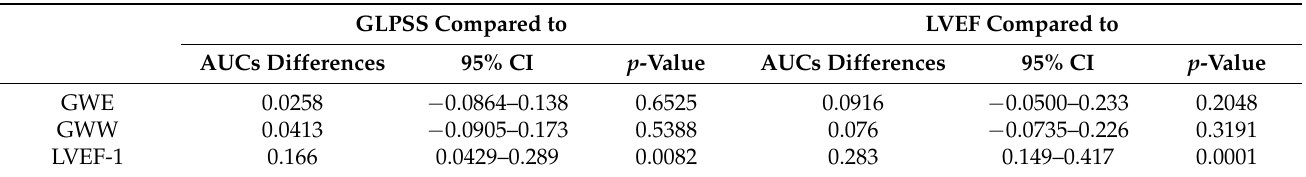
Table 6. Differences in the AUCs between LVEF by the Simpson’s method or GLPSS and GWW, GWE and LVEF-1.